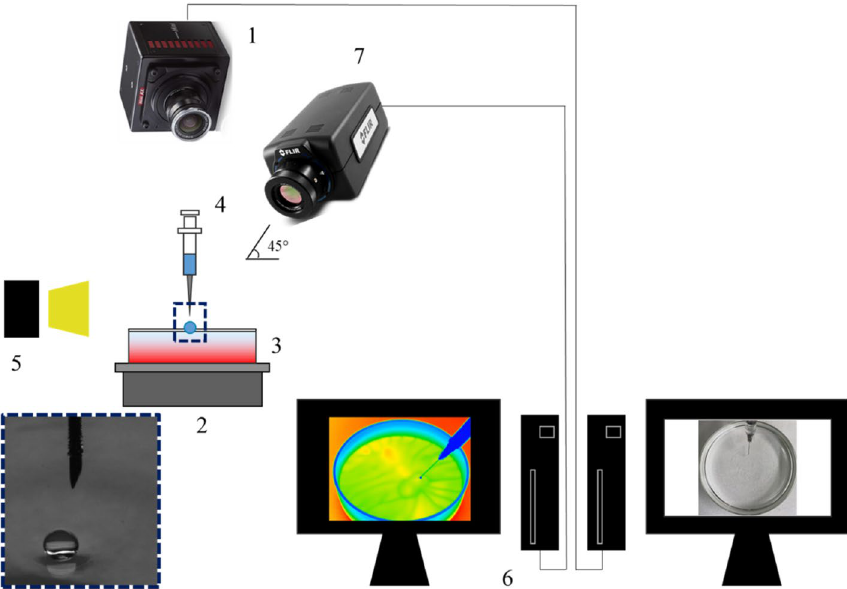
Figure 4. Illustration of the experimental setup. (1) Digital video camera, (2) heater (hot plate), (3) glass vessel, (4) syringe, (5) LED light, (6) computer, and (7) IR camera. Inset picture represents the droplet of diameter 2.0 mm (and needle tip), immediately after the levitation on the heated